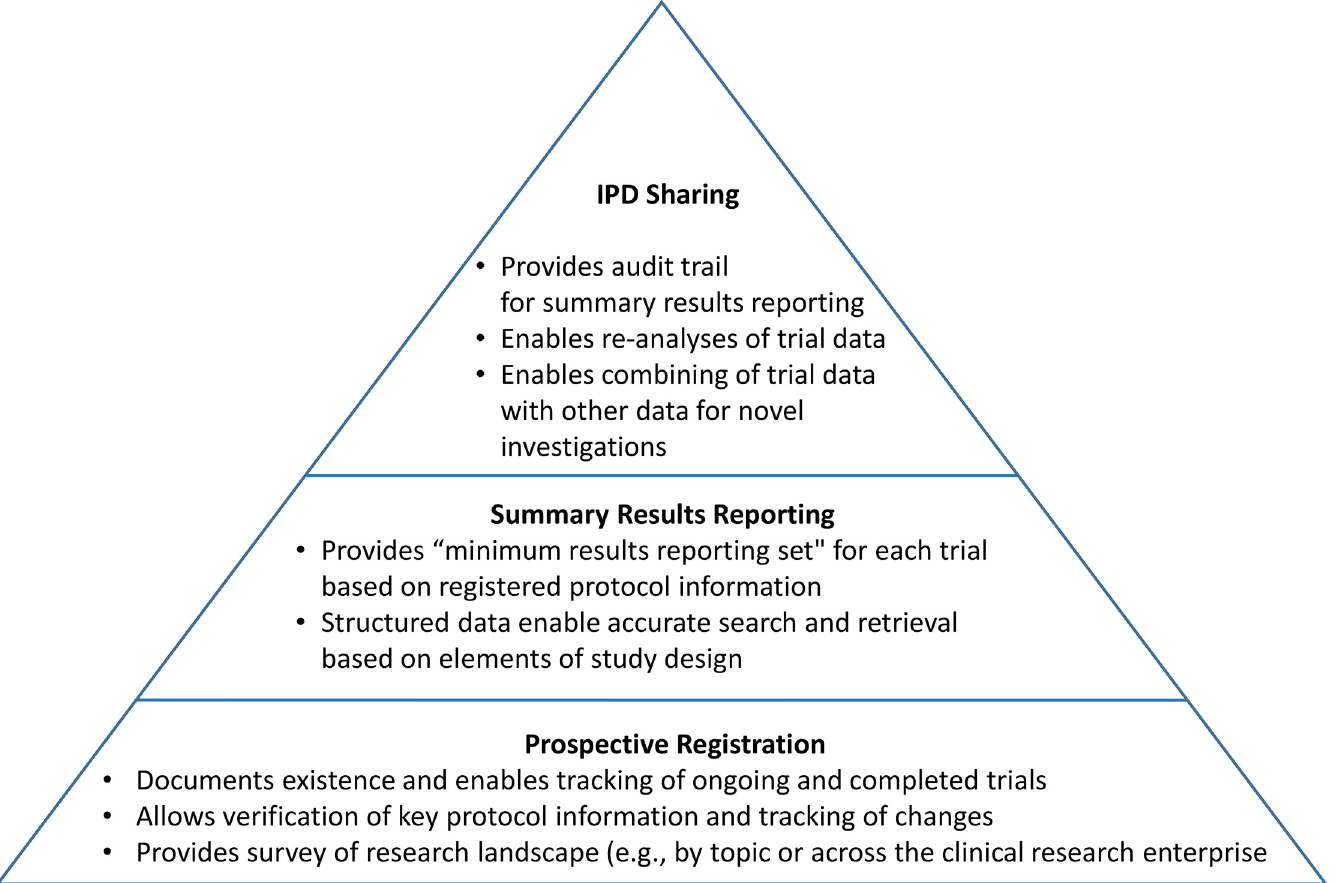
Fig 2. Schematic depicting the functions of the three key components of the